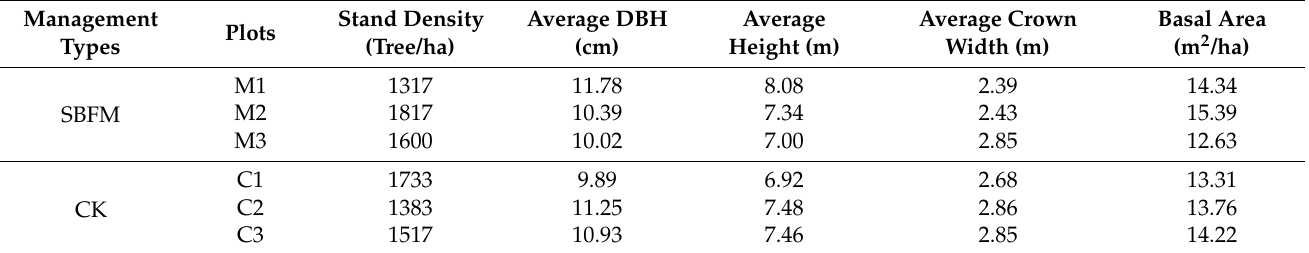
Table 1. The basic stand characteristics of the